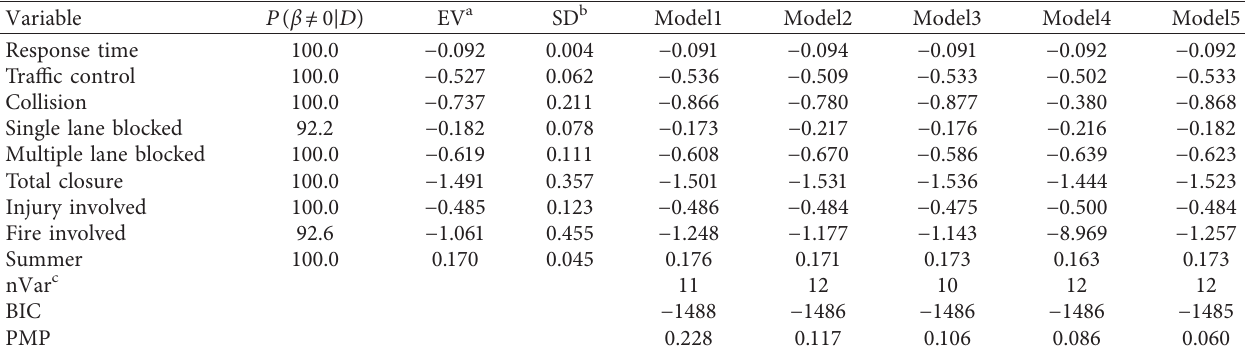
Table 2: Selected models with the highest posterior probabilities using